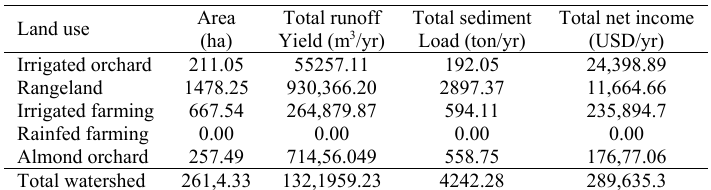
Table 5: Runoff yield, sediment load and net income of different land uses after optimization